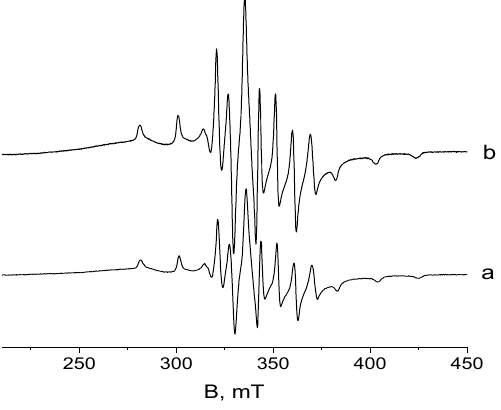
Figure 9. EPR spectra of TiO 2 / WO 3 photocatalyst before ( a ) and after 10 min ( b ) of UV light illumination.